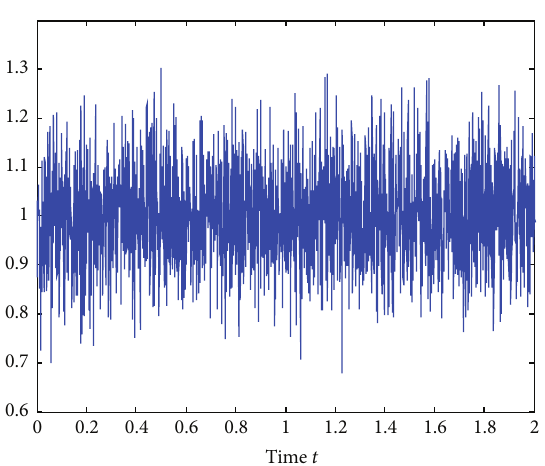
Figure 3: Random coupling strength 𝑐 3 (𝑡) .